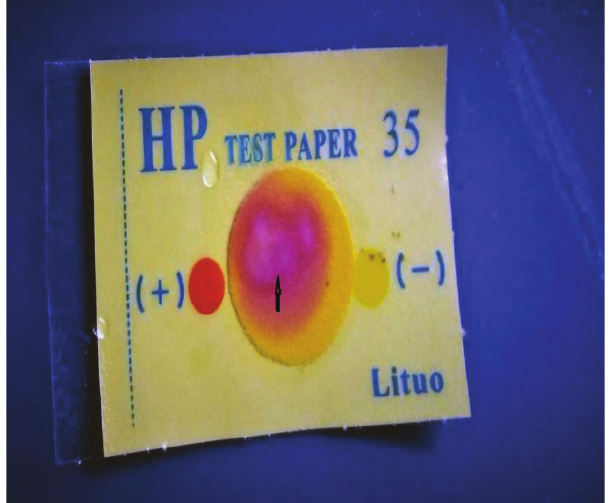
Fig-1: Rapid Urease Test, strong positive result, Test paper turns from yellow to cherry red